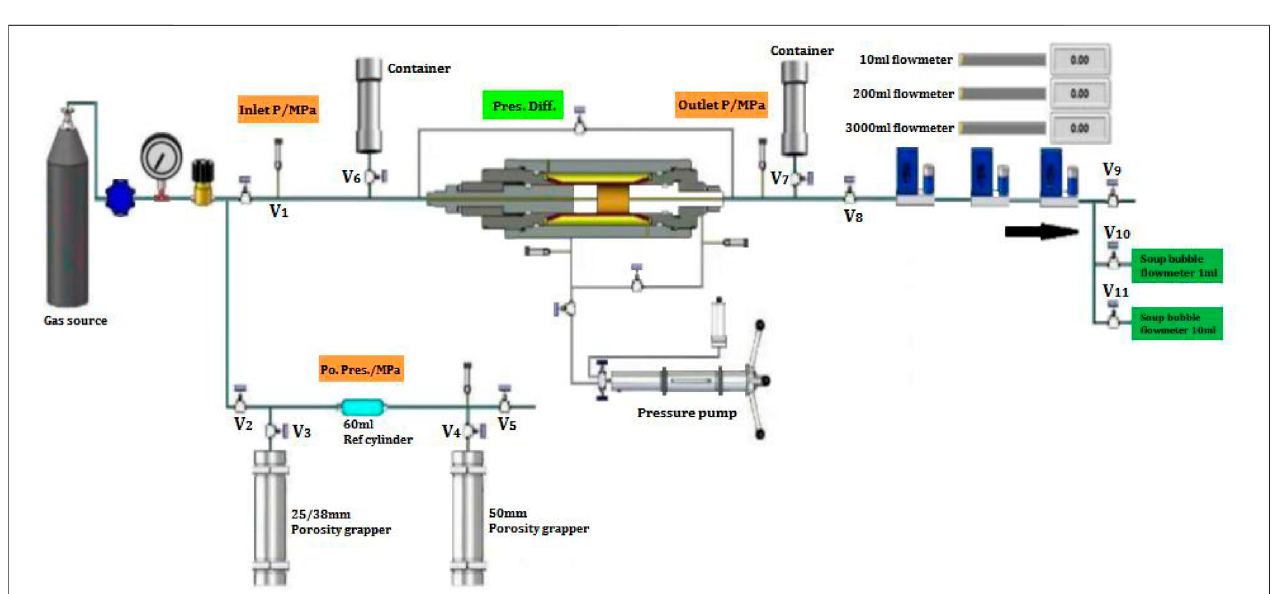
FIGURE 3 | Flow chart of rock porosity and permeability testing